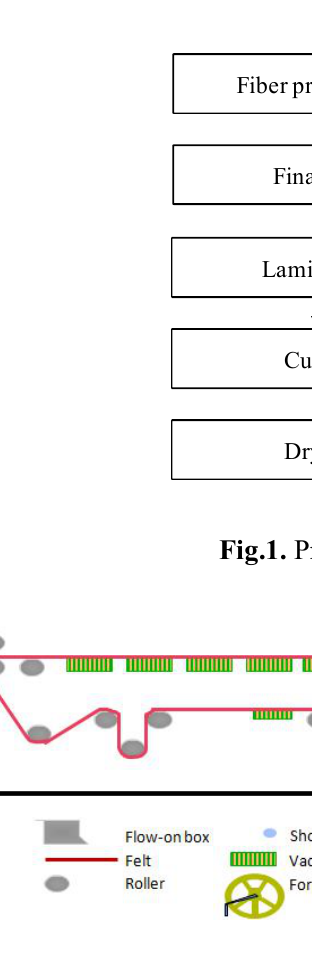
Fig. 2. Schematic view of the Flow-on process machine used for laminating of the fibre cement